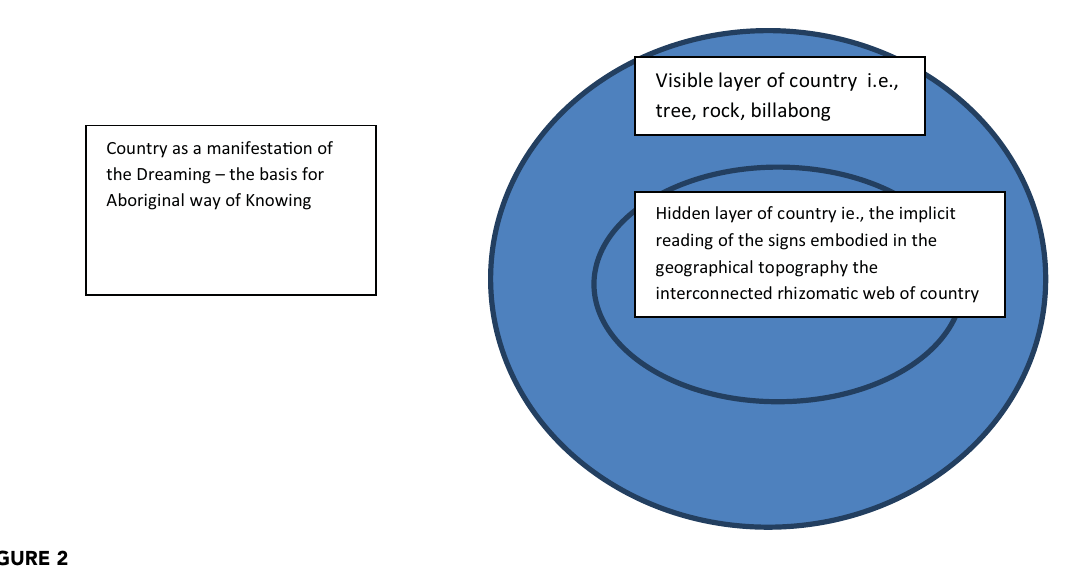
(Colour online) Layers of knowledge embedded in